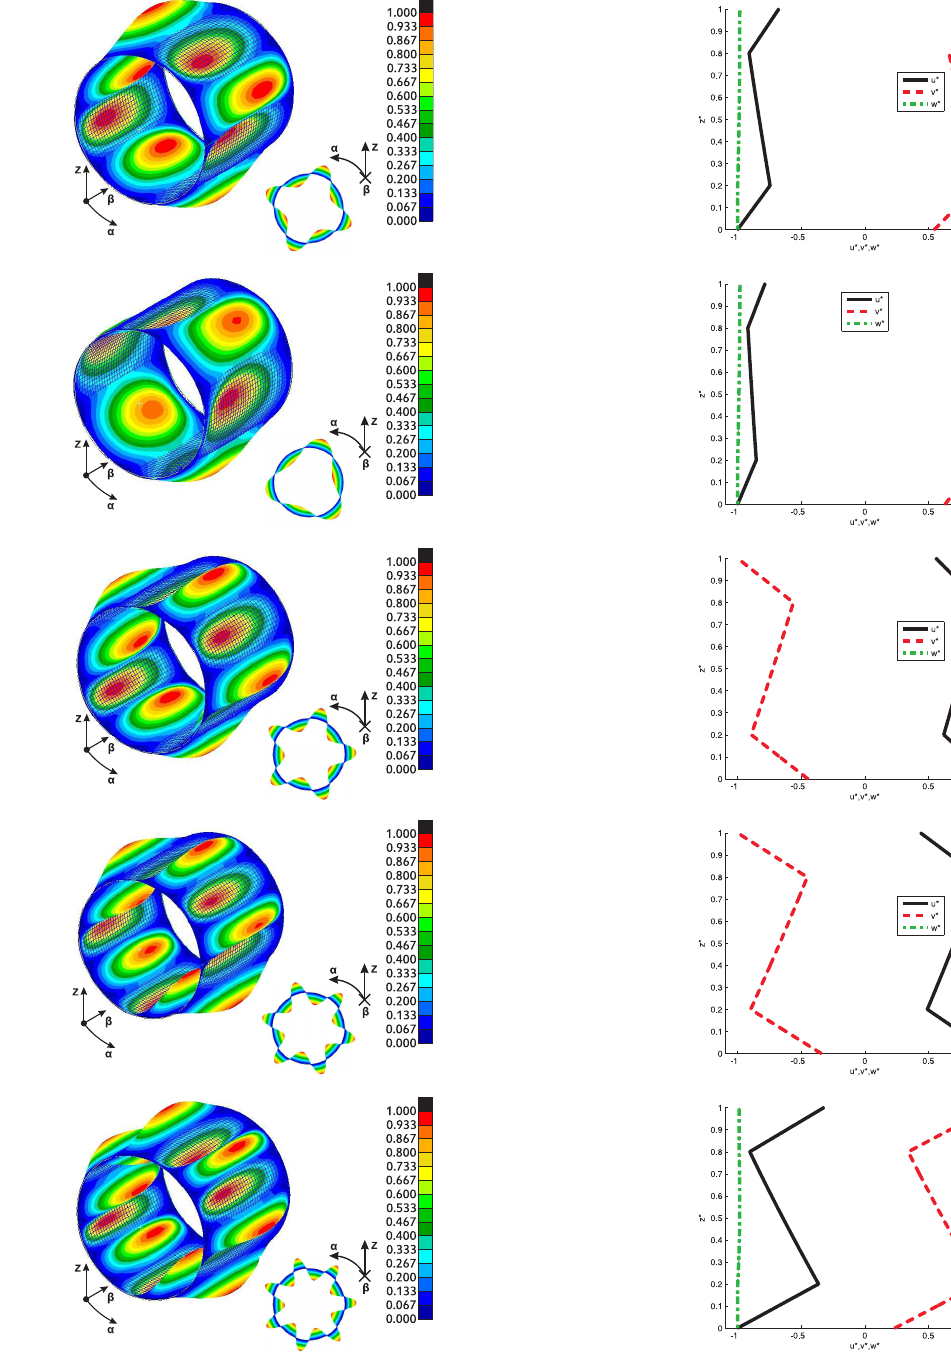
Figure 15: Twelfth benchmark, simply supported sandwich cylinder embedding isotropic skins and PVC core with thickness ratio R α /h=10. First five frequencies (with transverse displacement w ≠ 0) via 2D FE solution (on the left) and via 3D exact solution (on the right).